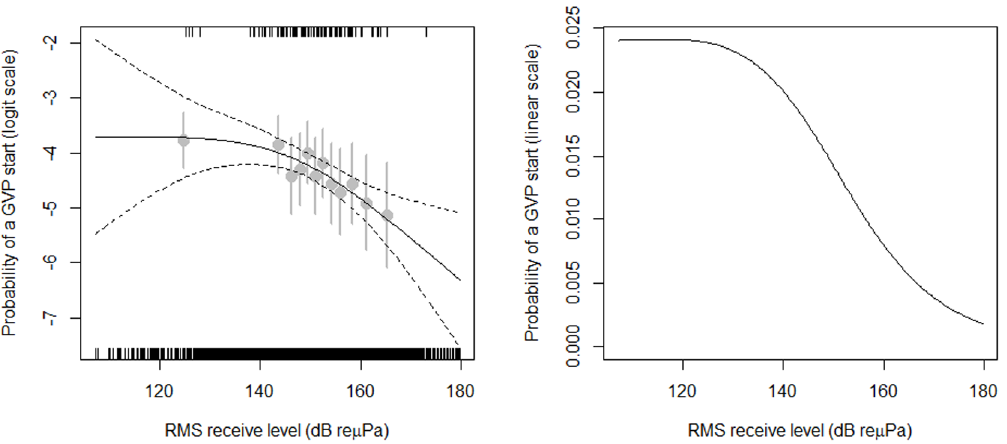
Figure 1. Estimated probability of a GVP start as a function of maximum RL rms in a 30 minute segment on a given hydrophone on the logit (left plot) and linear (right plot) scale. Dashed lines indicate pointwise 95% confidence limits on the fitted relationship. Short vertical lines at the top and bottom of the plots show the data used in the model: those at the top indicate the RL rms where GVP starts were observed, while those at the bottom of the plots indicate RL rms where GVP starts were not observed. The grey dots provide a summary of these data, and can be used to assess the goodness-of-fit of the fitted relationship – they are the proportion of the data where a GVP start was observed, each calculated using approximately 1/12 th of the data going from lowest to highest RL. Grey vertical lines indicate 95% binomial confidence intervals on these proportions.